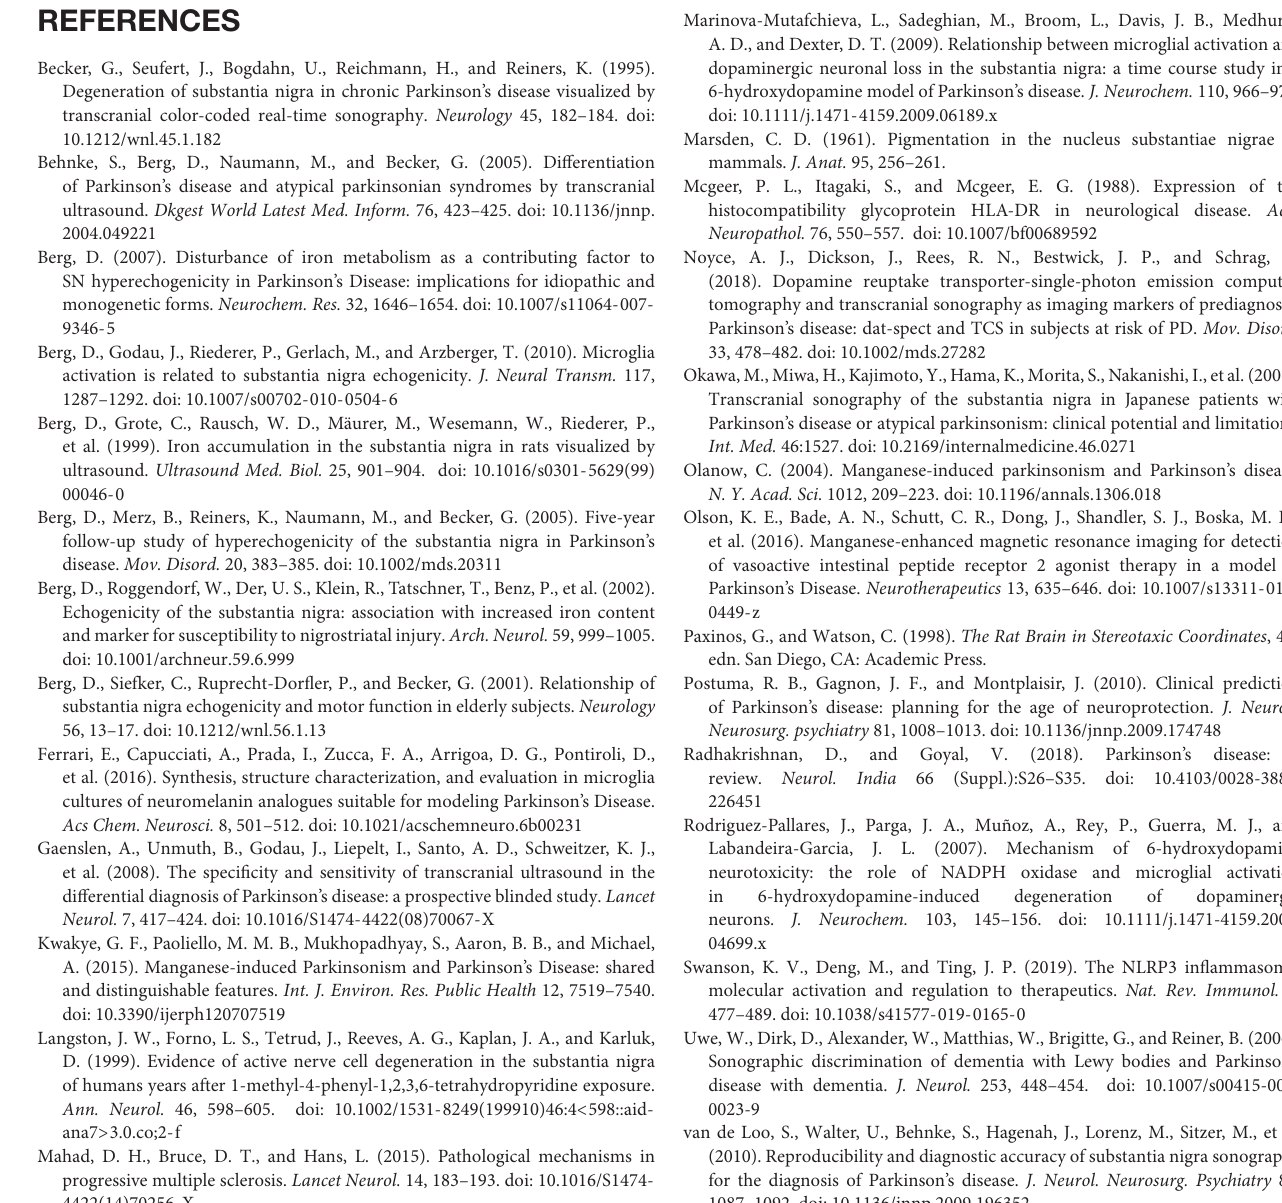
P = 0.1911, t = 1.572, df = 4, F = 1.384. Striatum of the 6-OHDA group: P < 0.0001, t = 46.68, df = 4, F = 1.385. Substantia nigra of the vehicle group: P = 0.4934, t = 0.7529, df = 4, F = 1.439. Substantia nigra of the 6-OHDA group: P < 0.0001, t = 22.86, df = 4, F = 32.66. ∗∗∗∗ P < 0.0001. # Comparison between different groups. ns P > 0.05, # P < 0.05, #### P < 0.0001, ** P < 0.01, *** P < 0.001, **** P < 0.0001. FIGURE S2 | (A) Immunochemistry staining with tyrosine hydroxylase (TH) antibody showing TH-immunoreactive cells. (B) Western blot showing the TH protein level. (C) Statistical result of the TH protein expression levels. One-way ANOVA. Cortex: P = 0.3580, F = 1.225. Striatum: P < 0.0001, F = 593.3. Substantia nigra: P < 0.0001, F = 6452. # Comparison between different groups. ns P > 0.05, # P < 0.05, #### P < 0.0001, ** P < 0.01, *** P < 0.001, **** P <